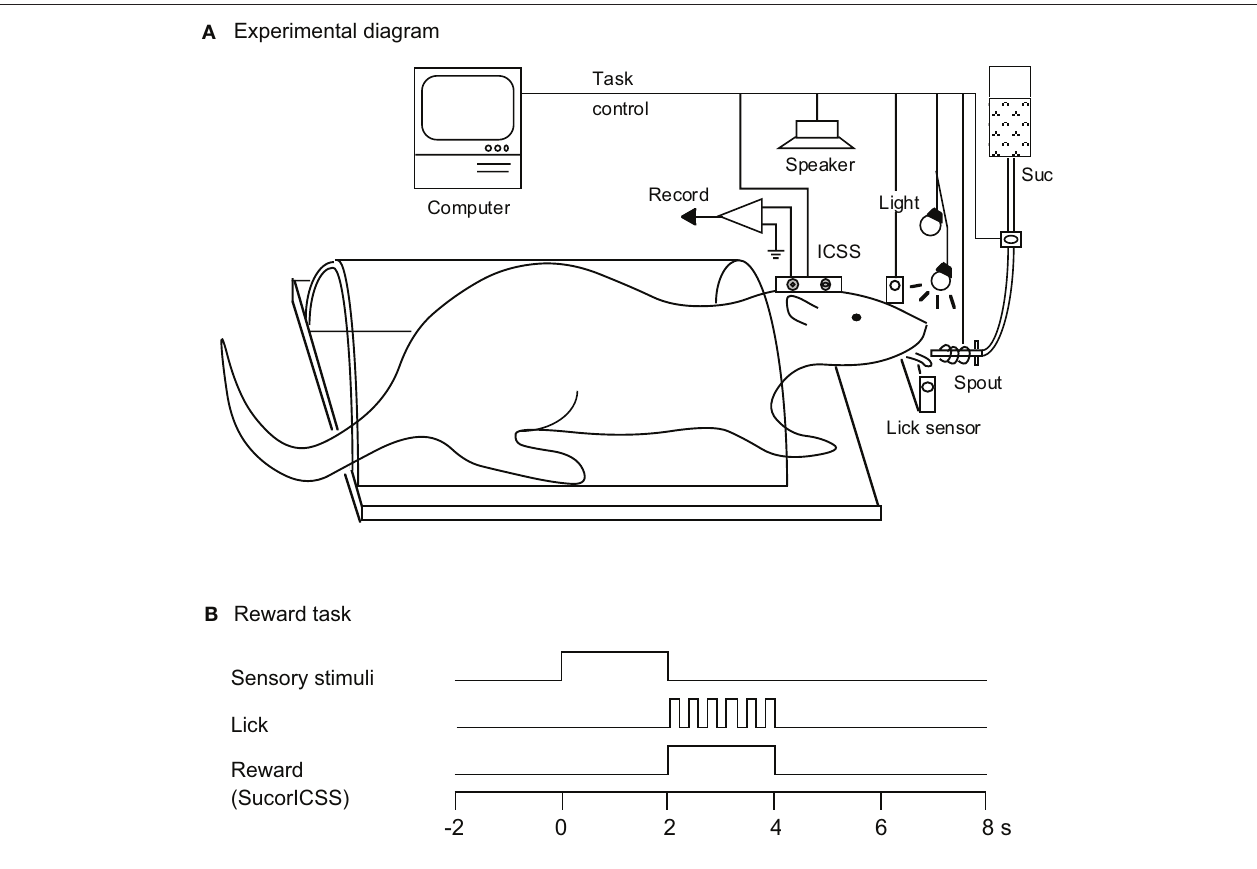
front of each eye, respectively. A sucrose solution was delivered from a spout, and electric current for the ICSS was applied to the stimulating